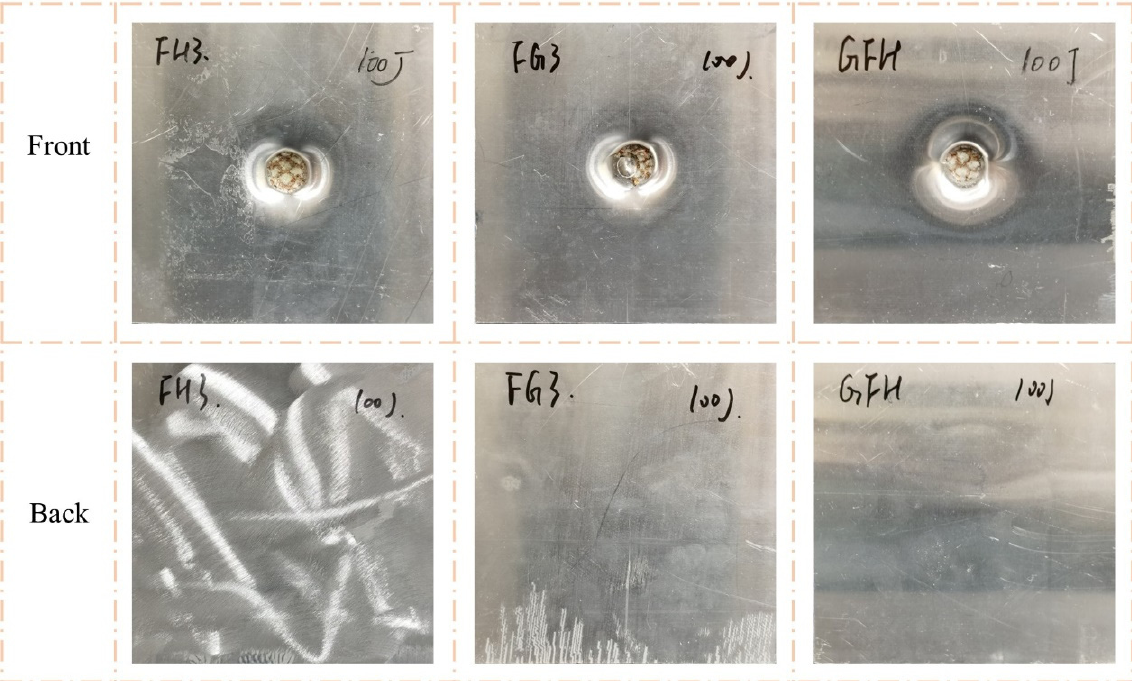
Figure 9. Damage modes of FH3, FG3, and GFH under 50 J impact energy with hemisphere impactor.